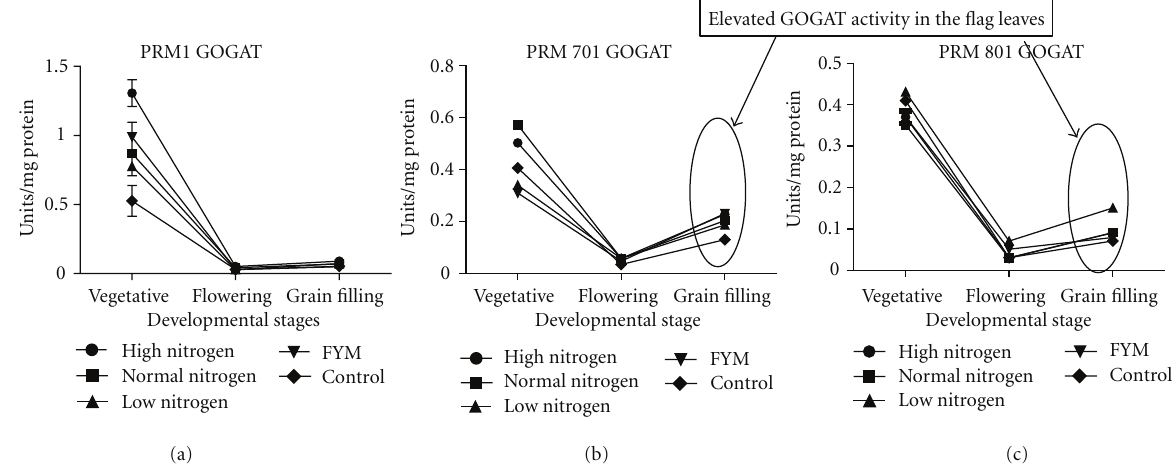
Figure 4: Influence of nitrogen fertilization on glutamate synthase (GOGAT) enzyme activity (specific activity) at various developmental stages of finger millet genotypes (a) brown PRM-1, (b) golden PRM-701, (c) white PRM-801.